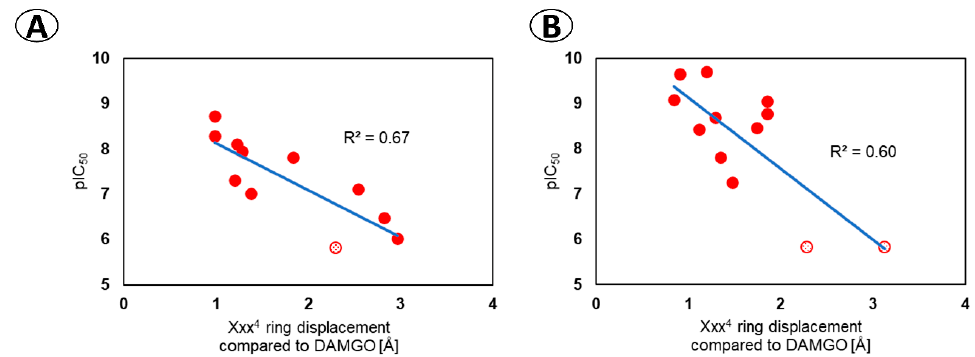
Figure 5. Correlation between the displacement of the ring of the fourth residue predicted by docking and the experimental µOR affinity. The relationship for ( A ) the α / β -peptides reported in this work, ( B ) derivatives reported in Reference [9]. The ring displacement is expressed as the RMSD of Xxx 4 ring in the considered derivative (as predicted by docking) compared to N -Me-Phe 4 ring in DAMGO (6DDF structure [31]). The points marked with dotted texture are arbitrarily chosen 5.82 for pIC 50 being less than 6.